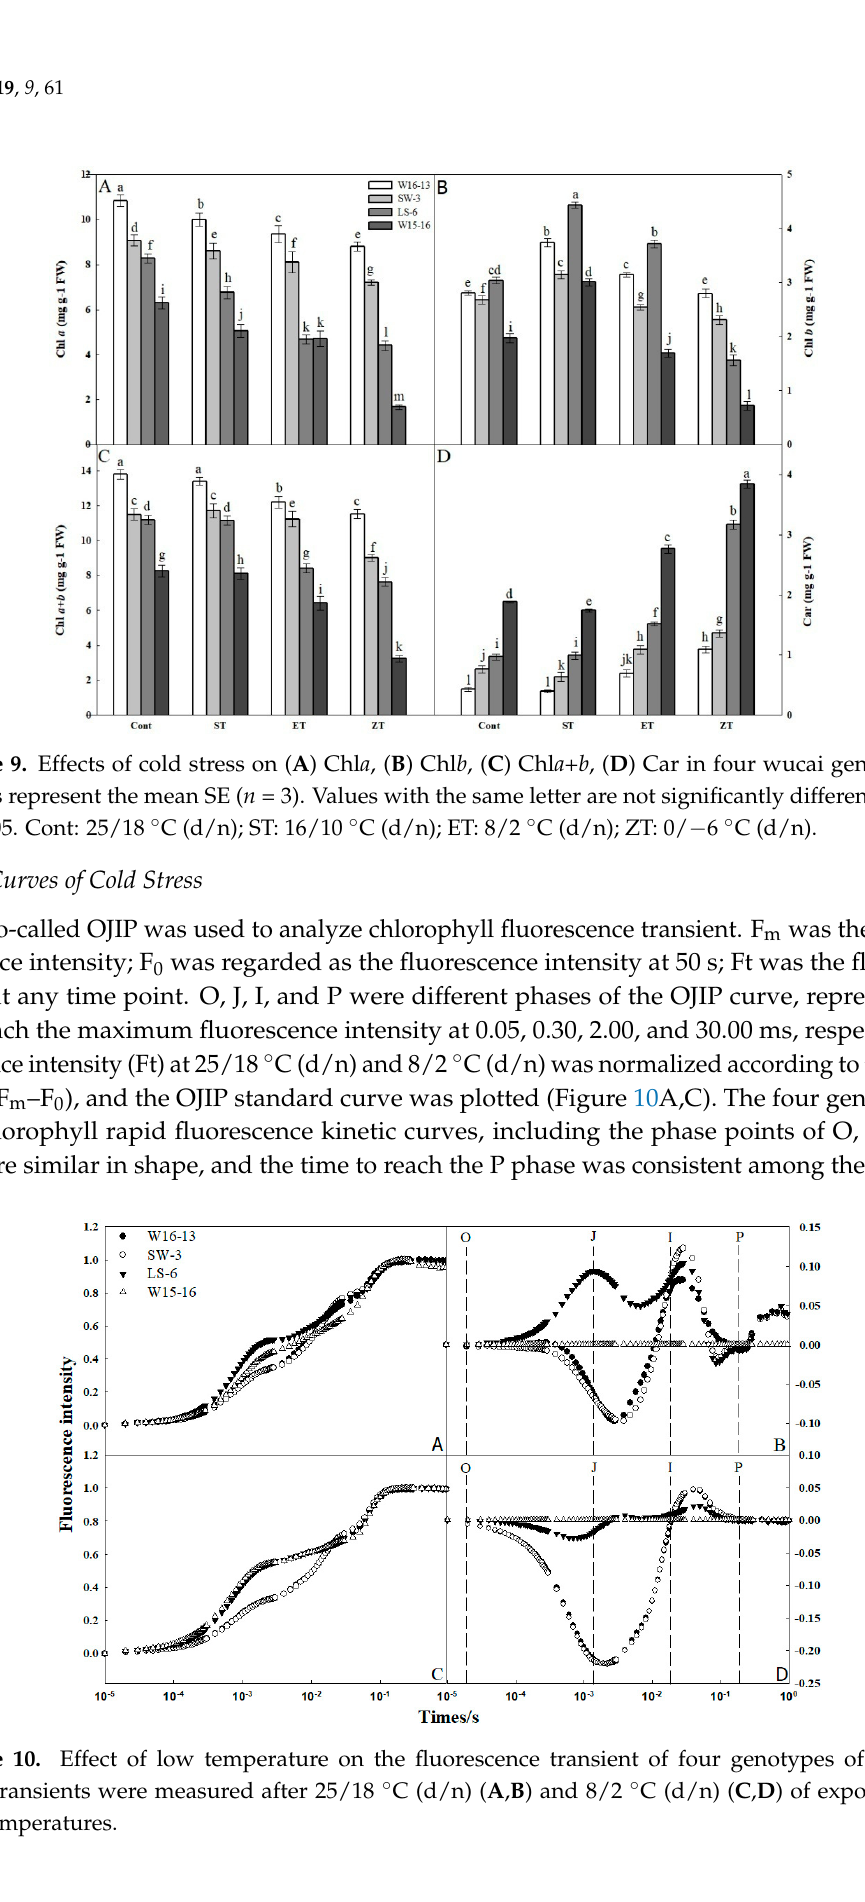
10 of 19 Figure 8. Variation in the response of four genotypes of wucai exposed to lowtemperature stress. Cont: 25/18 °C (d/n); ET: 8/2 °C (d/n). 3.3. Chlorophyll Content Among the four wucai genotypes, their changes in Chl a , Chl b , Chl a+b and Car contents